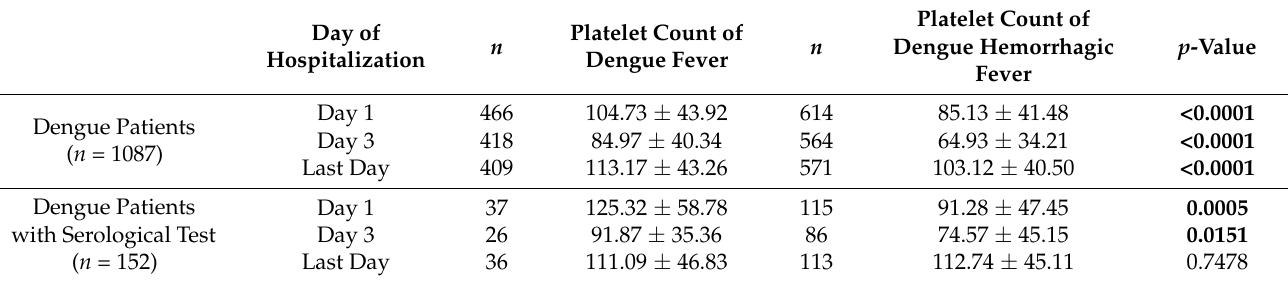
Table 5. Mean of Platelet Count between DF and DHF patients on Day 1, Day 3 and Last Day of